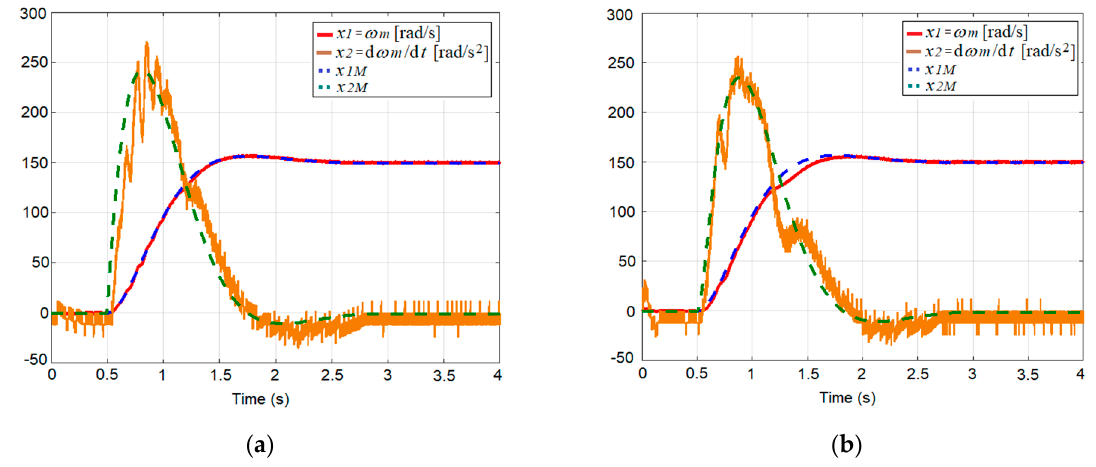
Figure 16. Motor starting at: ( a ) α = 5 and k T = [0.0031 0.0019 0.00038]; ( b ) α = 5 and k T = 0.25 [0.0031 0.0019 0.00038].